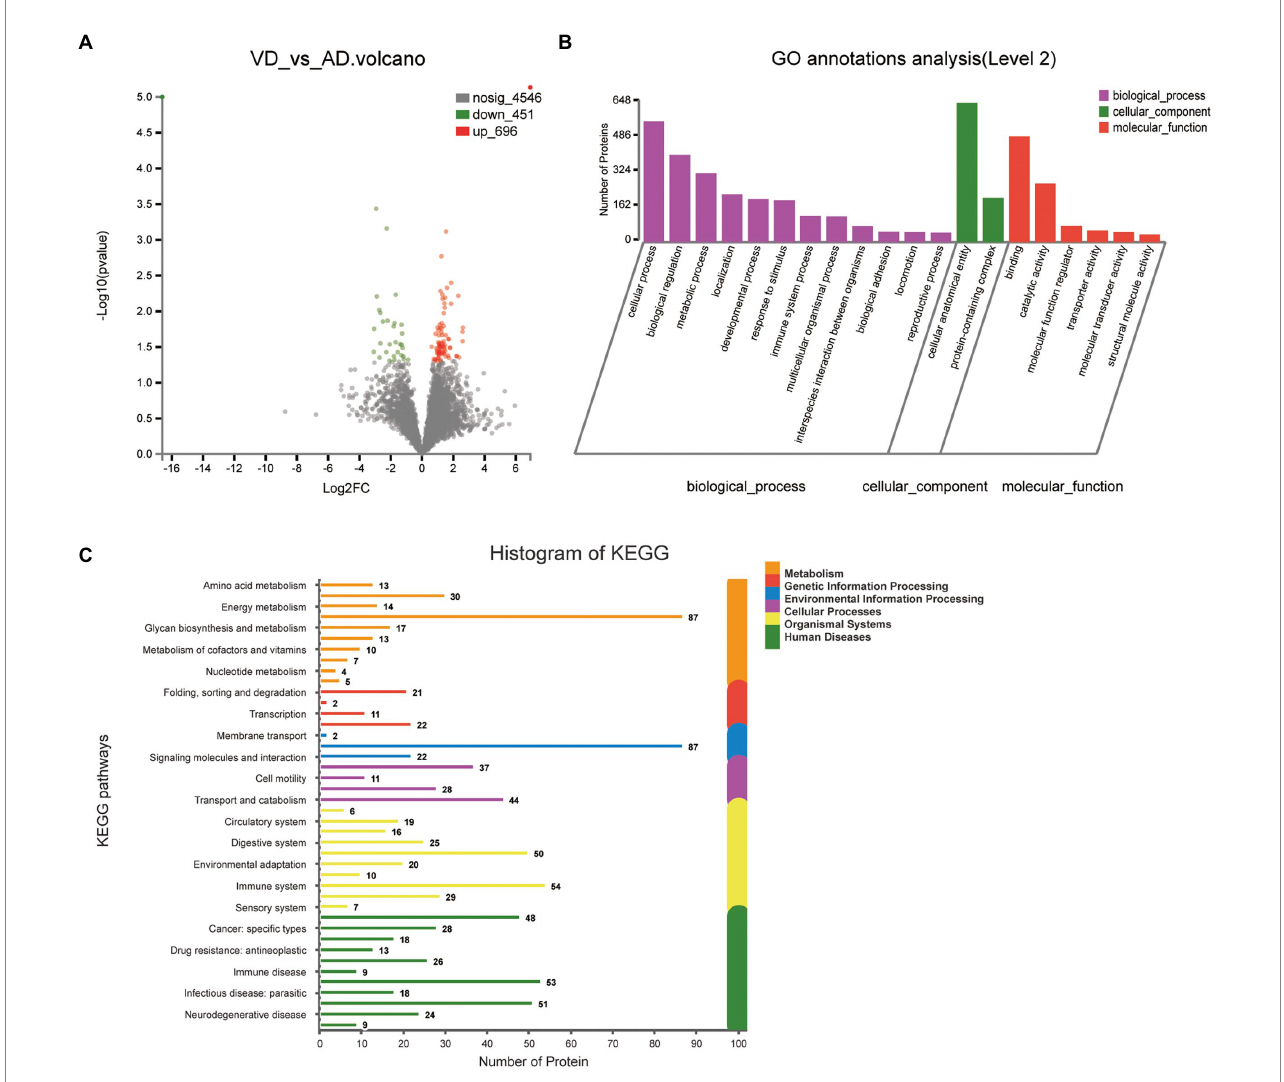
FIGURE 4 Volcano plots of quantified proteins and functional analysis of the differentially expressed proteins in the urine between VD and AD groups. (A) Venn chart of Urine-based Proteome analysis identified from VD vs AD. (B) GO enrichment analysis of differential urine-excretory proteins. Purple bars denote the enriched biological processes, green bars are enriched cellular components, and red bars are enriched molecular functions. Protein numbers enriched in each category are presented with the bars. (C) The differential expressed proteins are associated with diseases and signal transduction pathways. The number of proteins associated with each category is